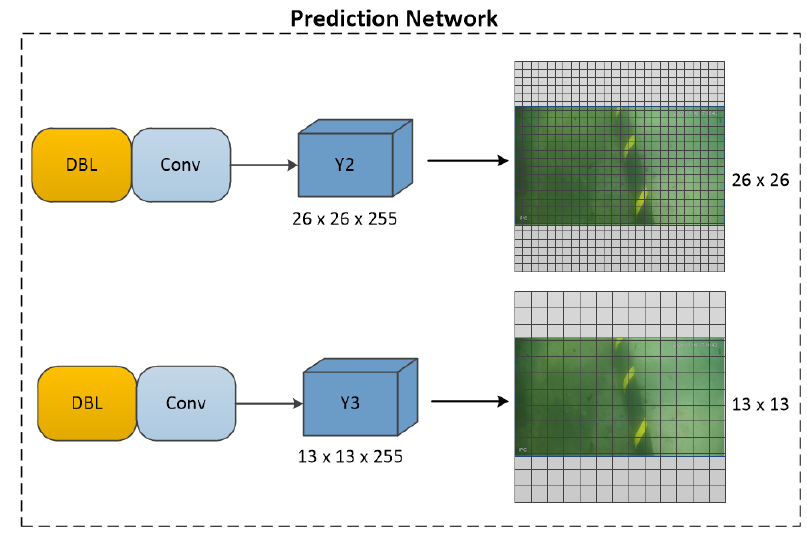
Figure 9. YOLO-SC prediction network